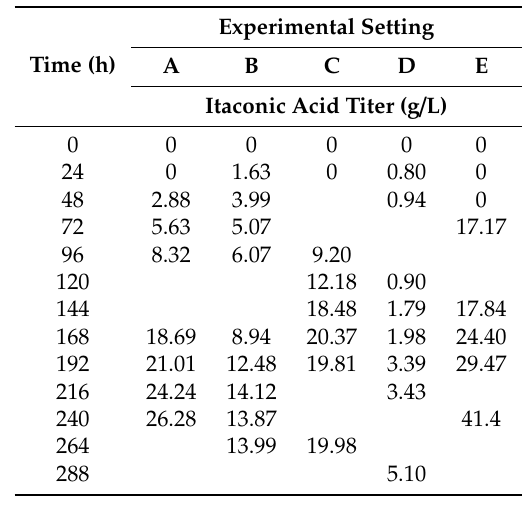
Table 2. Experimental itaconic acid production data.